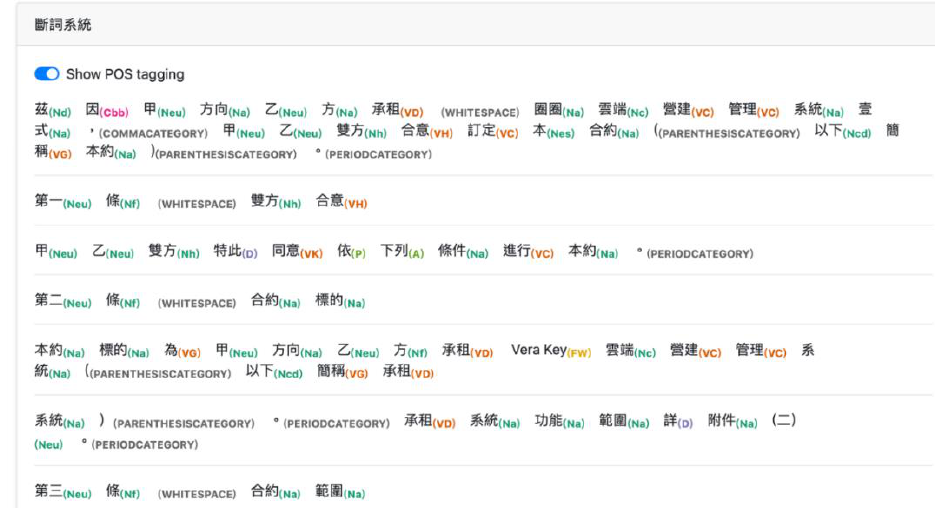
Figure 6. Illustration for word segmentation recognition (The result for word segmentation recognition converting all Chinese keywords to codes).